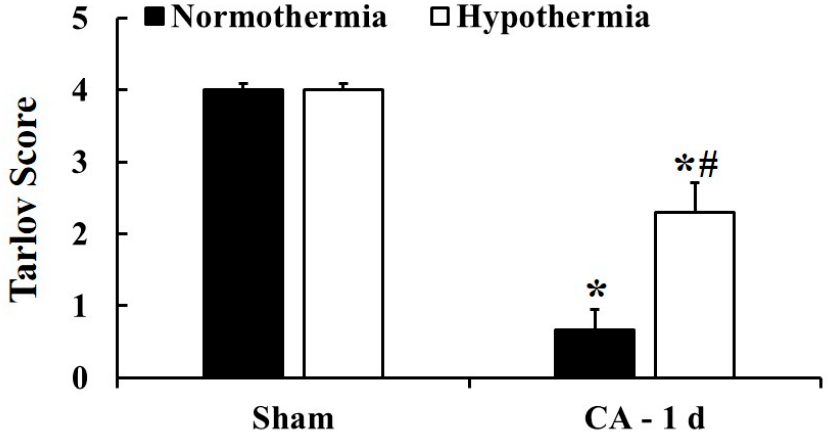
Figure 2. Neurological evaluation for hind limb motor function in the sham/normothermia, sham/hypothermia, ACA/normothermia, and ACA/hypothermia groups at 1 day after ACA. The ACA/hypothermia group shows a milder neurological deficit than the ACA/normothermia group.